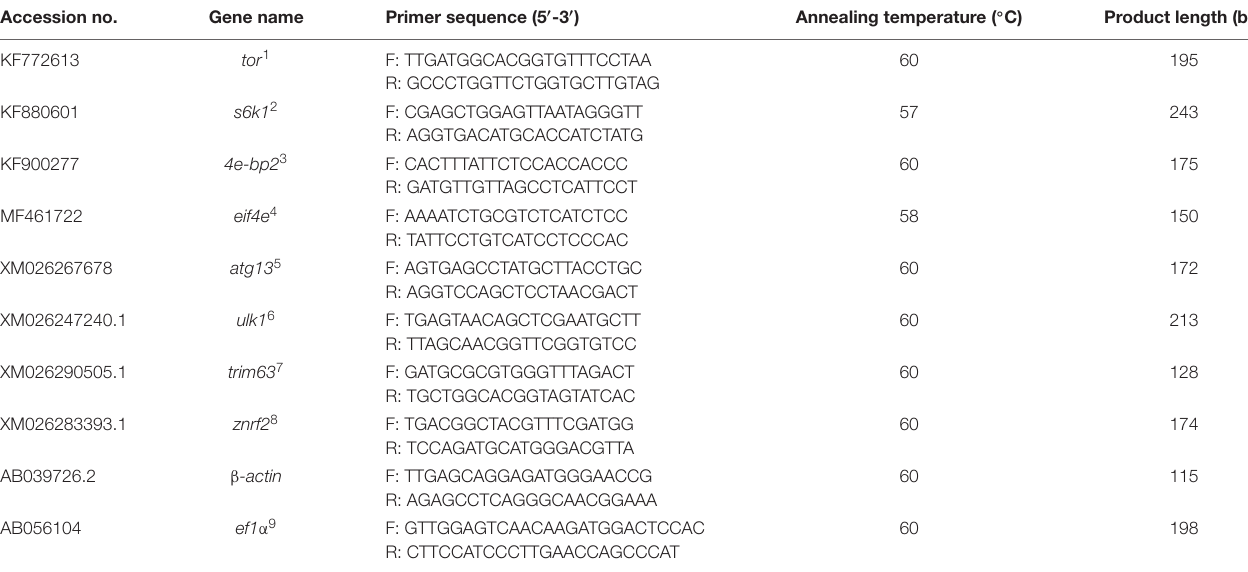
TABLE 4 | Primers used for quantitative RT-qPCR. Accession no.